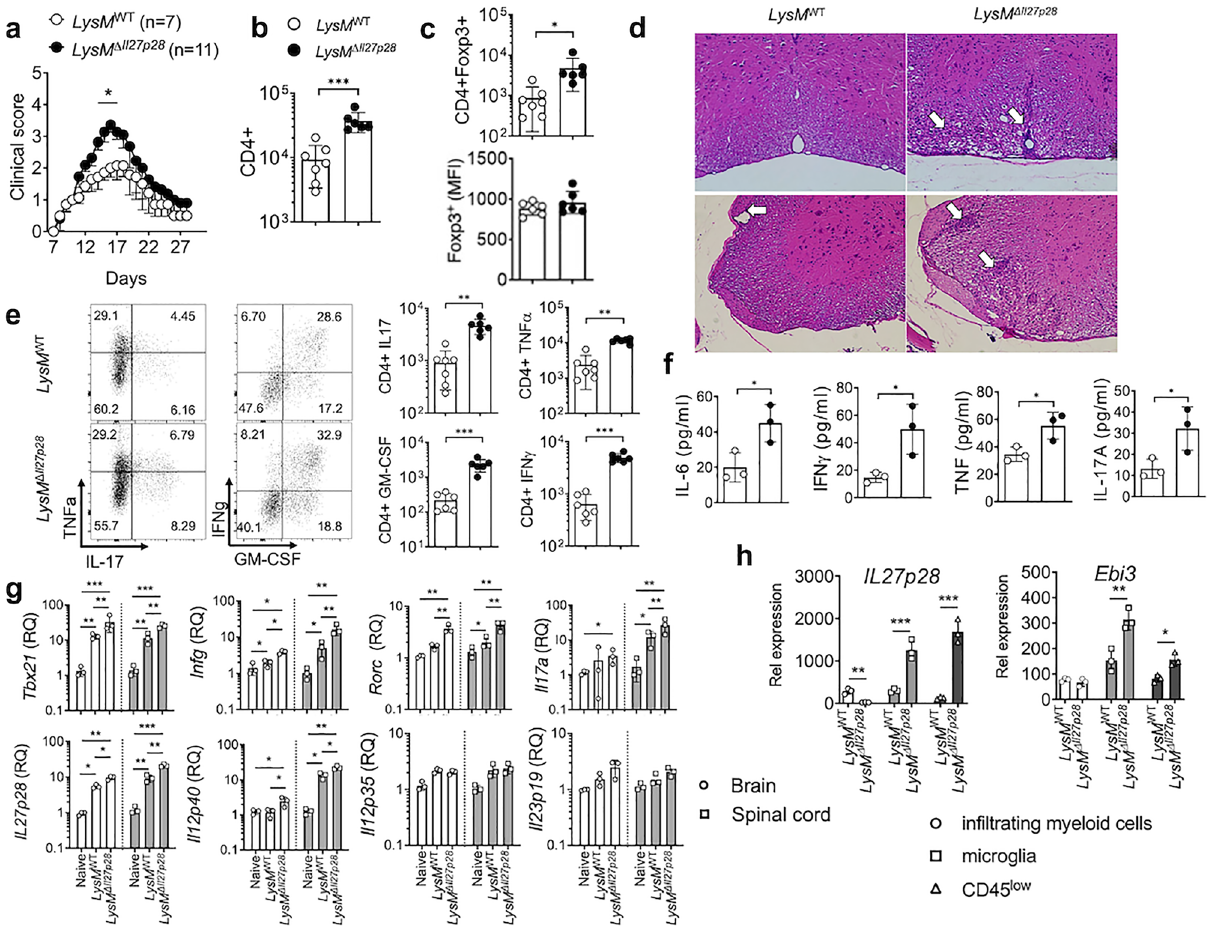
Figure 2. EAE in myeloid cell-specific Il27p28 −/− mice. LysM WT (n = 7) and LysM Cre Il27p28 fl/fl (LysM Δ Il27p28 ) (n = 11) mice were induced for EAE. ( a ) EAE clinical score. ( b , c ) The numbers of CNS infiltrating CD4 + and CD4 + Foxp3 + Treg cells, and the mean fluorescence intensity (MFI) of Foxp3 was determined by flow cytometry at day 17 post immunization. ( d ) At day 18 postimmunization, tissue sections of the spinal cords were stained with H&E. Arrows indicate infiltration of inflammatory cells. × 200 magnification. ( e ) Flow cytometry analysis of GM-CSF, IFNγ, IL-17, and TNFα CD4 + T cells from the CNS of EAE mice (day 17 post immunization). ( f ) The levels of IL-6, IFNγ, TNFα and IL-17A in the serum of EAE mice (day 17 post immunization) were measured using Cytometric Bead Array. Each serum sample was analyzed in duplicates. ( g ) qPCR analysis of the indicated mRNAs in the brain and spinal cords from naïve, LysM WT , and LysM Δ Il27p28 mice 17 days post immunization. Gene expression was normalized by Gapdh and compared to that of naïve mice. n = 3 per group. ( h ) qPCR analysis of the indicated mRNAs in freshly sorted CD45 high CD11b high (infiltrating myeloid cells), CD45 int CD11b high (microglia) and CD45 low (astrocyte and oligodendrocyte) cells from LysM WT or LysM Δ Il27p28 mice 17 days post immunization. n = 3 per group. *p < 0.05; **p < 0.01; ***p < 0.001; as determined by Mann– Whitney nonparametric CD4 T cells was similar in both proportions and absolute numbers. Consistent with these findings, expression of Ifng , Il17a , and Il1b mRNA in the CNS tissues was also similar between WT and DC-specific IL-30 −/− groups (Fig. 3f). Serum cytokine levels measured by cytokine bead array (CBA) were comparable between the groups (Fig. 3g). Inflammatory chemokine and IL-12 family cytokine expression in the tissues was similar between the groups (Supp Fig. 4a,b). Lastly, CNS APC subsets were FACS sorted as above, and IL-12 family cytokine gene expression was determined. Consistent with the EAE severity and overall immune responses, we found no dif- ferences in cytokine gene expression between the groups (Fig. 3h and not shown). Therefore, DC-derived IL-30 plays little role in regulating encephalitogenic immune responses. Microglia‑derived IL‑30 plays a similar regulatory role in EAE. Microglia are resident CNS glial cells capable of producing IL-27 31,32 . To target microglia expression of IL-27, Cx3cr1 Cre Il27p28 fl/f mice were used 33 . Microglia specific IL-30 −/− mice exhibited severe EAE analogous to myeloid cell specific IL-30 −/− mice (Fig. 4a). Assessment of total CD4 and Foxp3 + Treg cell CNS infiltration as well as of histopathology further support severe EAE phenotypes (Fig. 4b–d). Treg cell associated surface marker and Foxp3 expression remained unchanged in microglia-specific IL-30 −/− mice (Fig. 4c and data not shown). CNS infiltrating CD4 T cell expres-